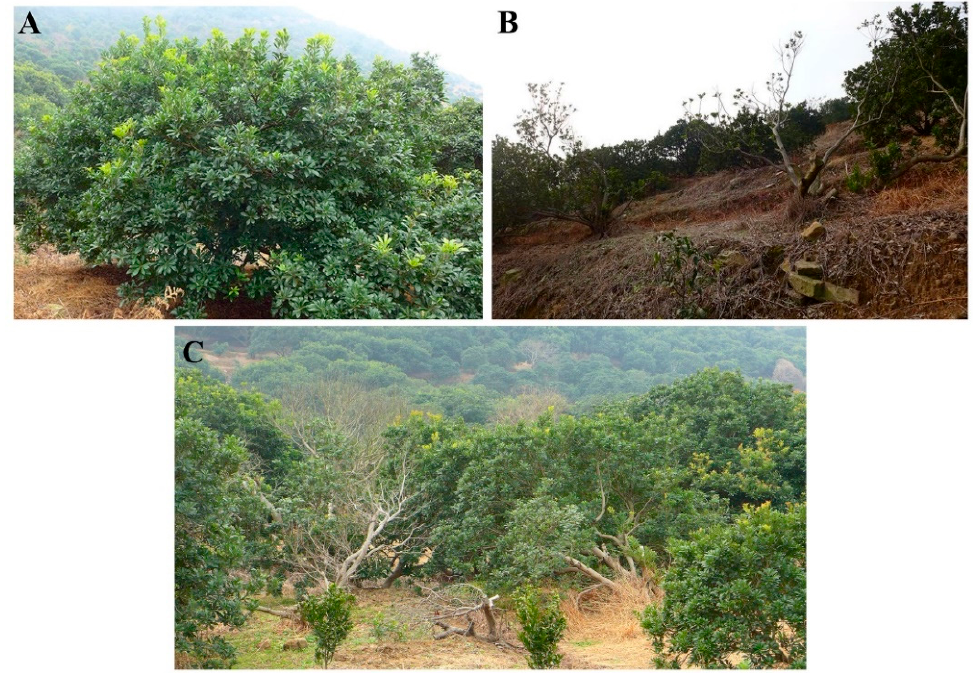
Figure 1. Bayberry trees orchard investigated in this study. Healthy ( A ) and diseased ( B ) bayberry trees and the distribution ( C ) of healthy and diseased bayberry trees.